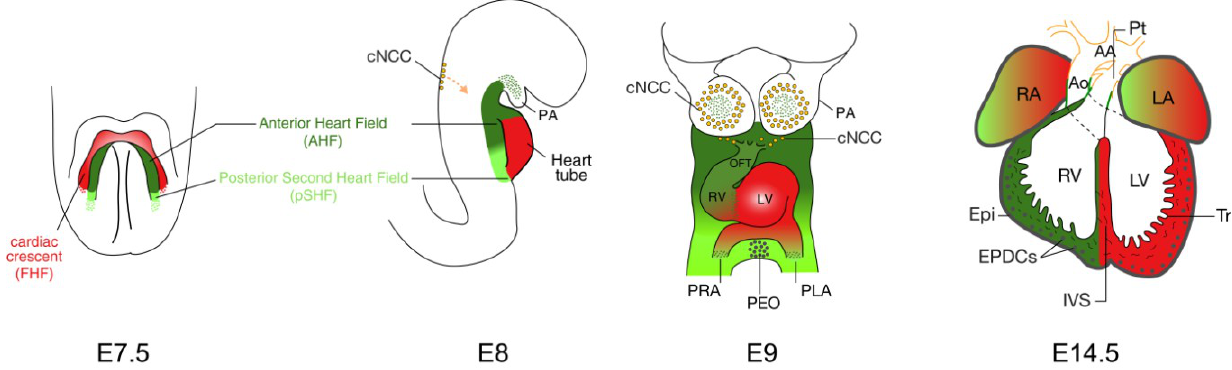
Figure 1. Heart development and the contribution of cardiac lineages in the mouse. At E7.5, myocardial cells form the cardiac crescent (also called first heart field, FHF), with the second heart field (SHF) lying medial to it. The location and contribution of the SHF are shown in green, with the anterior heart field (AHF) subdomain in dark green and posterior SHF (pSHF) in light green. At E8, the early cardiac tube forms through fusion of the cardiac crescent at the midline and it subsequently undergoes looping (E9). At fetal stage (E14.5), the epicardium (Epi) envelops the heart, the chambers are separated by the interventricular septum (IVS) and are connected to the pulmonary trunk (Pt) and aorta (Ao). The FHF and SHF contributions are shown in red and green respectively. The tunica media of the Ao and Pt is derived from SHF (green) and cardiac neural crest cells (cNCC; orange). AA, aortic arch; EPDCs, epicardium-derived cells; LA, left atrium; LV, left ventricle; OFT, outflow tract; PA, pharyngeal arch; PEO, pro-epicardial organ; PLA primitive left atrium; PRA, primitive right atrium; RA, right atrium; RV, right ventricle; Tr,